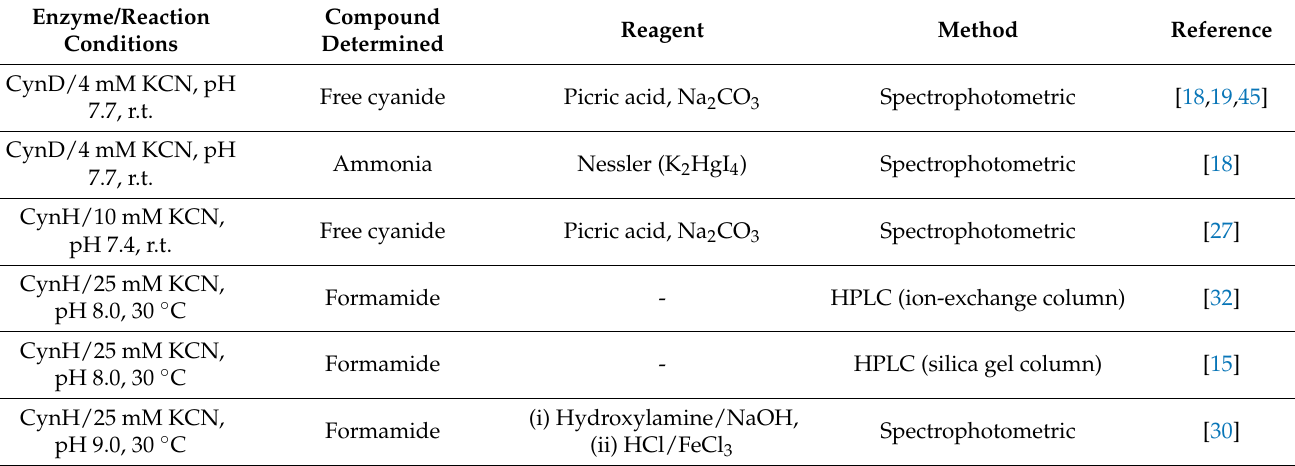
Table 4. Cyanide (di)hydratase activity